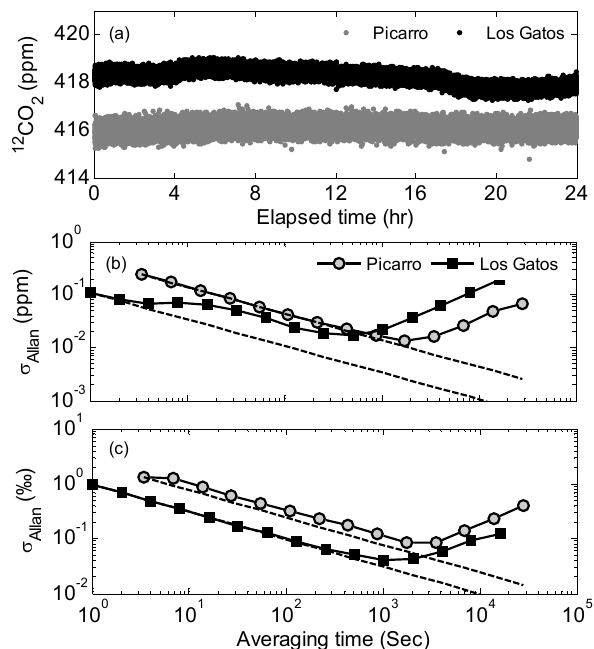
Fig. 1. Time series of the (a) 12 CO 2 concentration and Allan devia- tion of the (b) 12 CO 2 concentration and (c) δ 13 C for the Picarro G1101-i and the Los Gatos DLT-100 analyzer. The dashed lines show the expected behavior of the Allan deviation versus time for random white